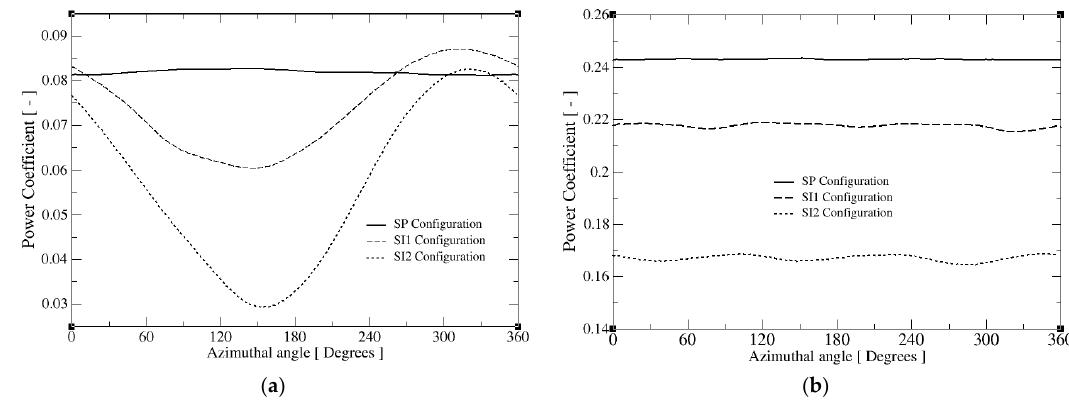
Figure 5. The power coefficient at λ = 5.7 for the three studied configurations, SP, SI15 (15°) and SI30 (30°) inclined with respect to the flow direction: ( a ) one blade; ( b ) complete turbine.